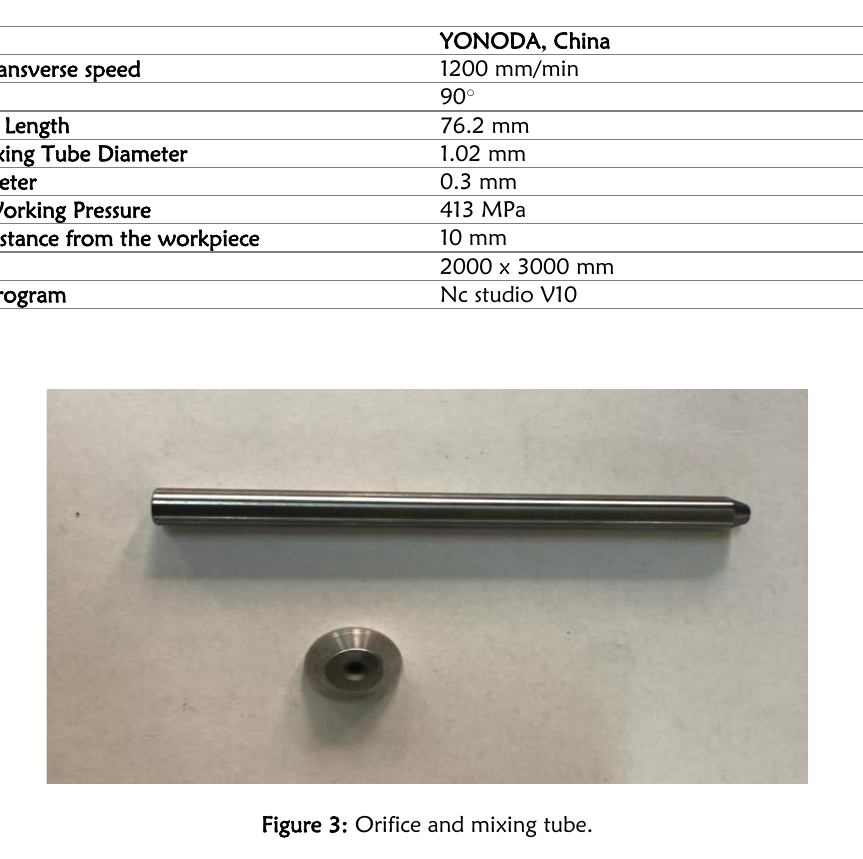
Table 3: Technical Specifications of AWJM